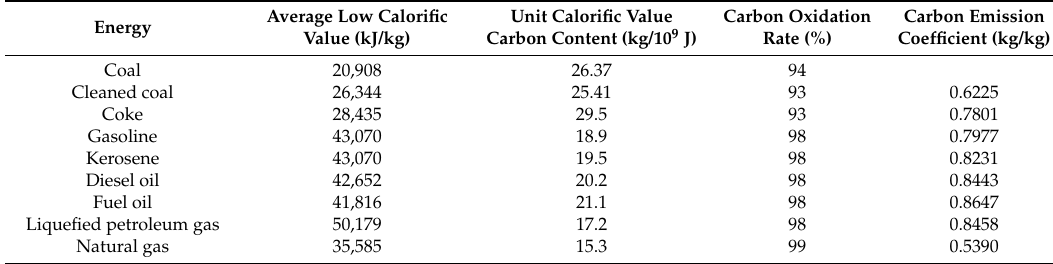
Table 3. Values of the parameters required for estimating carbon emissions from energy consumption. Energy